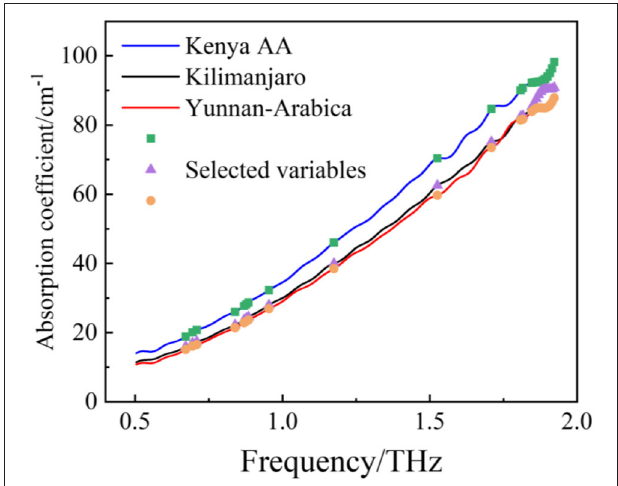
FIGURE 6 | The final result of the GA method for variable selection.